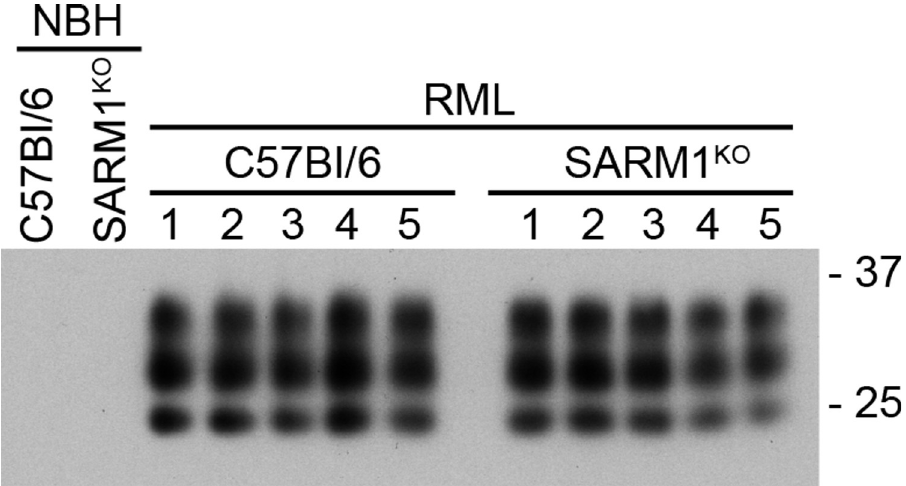
Fig 3. SARM1 KO and C57Bl/6 mice infected with RML prions accumulate similar levels of PrP Sc in the brain. Western blot analysis of PrP Sc in the brains of C57Bl/6 and SARM1 KO mice inoculated with RML prions (RML) or normal brain homogenate (NBH). All samples were PK-treated as described in the materials and methods. The sample number is given above each lane. As a negative control, the first two lanes show a single C57Bl/6 or SARM1 KO mice inoculated with NBH. Unlabeled lanes are empty. The blot was developed using the anti-PrP mouse monoclonal antibody 6D11. Molecular mass markers in kilodaltons are shown on the right.